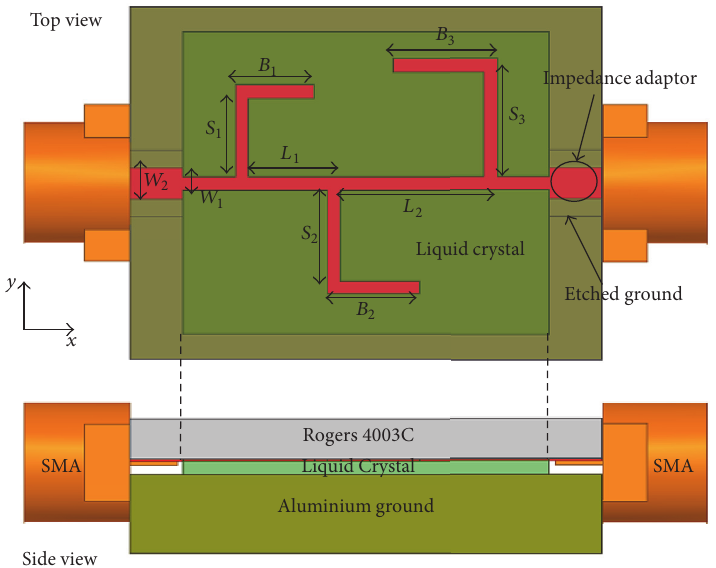
Figure 1: Schematic diagram of the proposed LC based tunable wideband